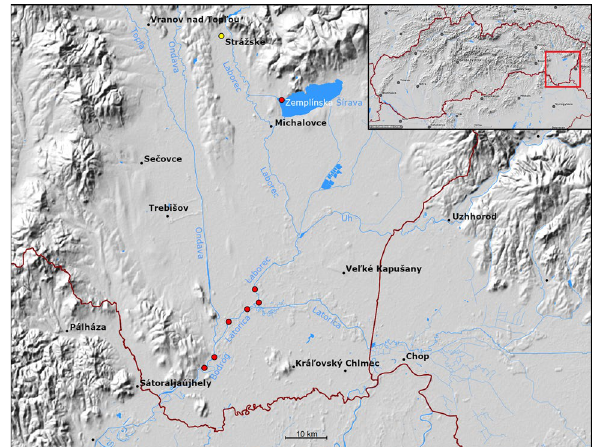
Figure 5. The map shows the sampling sites (red dots) of Wels catfish ( Silurus glanis ) from the Zemplínska Šírava reservoir and the Laborec, Latorica and Bodrog Rivers. The chemical factory in the town of Strážske in yellow. Details of the fish samples can also be found in Table S1 in the supplementary material.